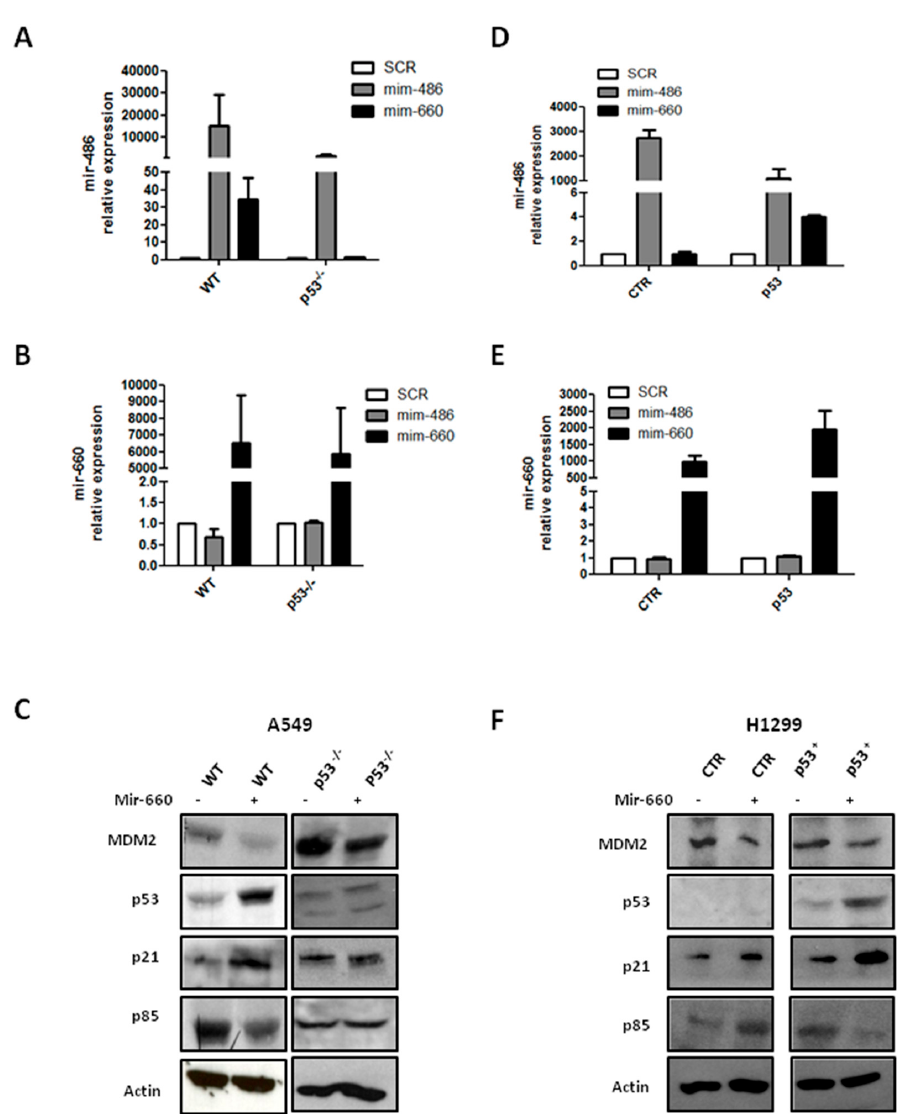
Figure 4. p53 is fundamental for mir-660-5p-dependent regulation of mir-486-5p. ( A , B ) Relative mir-486-5p ( A ) and mir-660-5p ( B ) expression in A549 WT and p53 − / − ; ( C ) MDM2/p53 axis and their downstream genes levels in A549; ( D , E ) relative mir-486-5p ( D ) and mir-660-5p ( E ) expression in H1299 CTR and p53 + ; ( F ) H1299-p53 + mir-660-5p over-expressing cells by Western blot analysis. All data are expressed as mean ± SEM ( n = 2 for each cell).